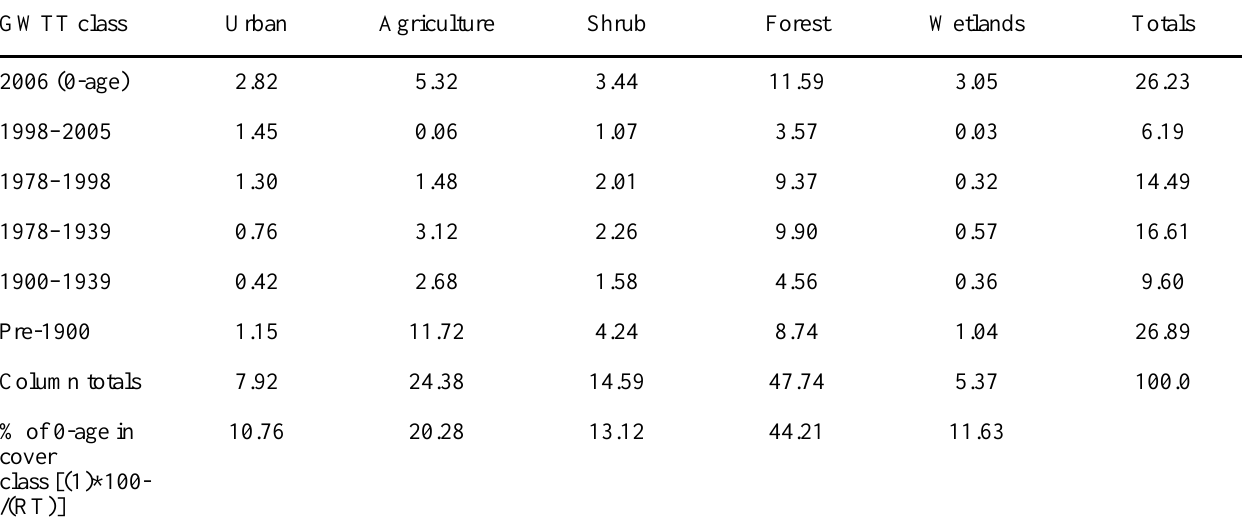
Table 2. Cross-tabulation of current land-use maps and groundwater travel-time maps categorized by land- change submodel. Values are expressed as (A) percent of total groundwatershed and (B) percentage of land-use/cover class in a groundwater travel-time class in which each class represents a backcast land- change